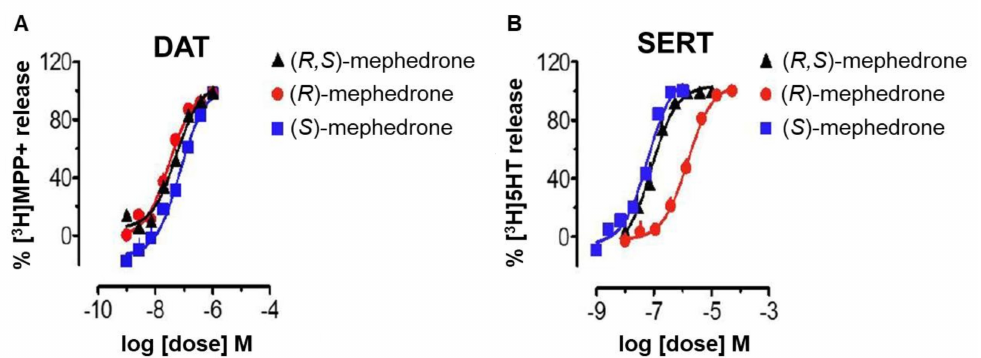
Figure 12. Effects of the enantiomers and racemate of mephedrone on monoamine release via DAT and SERT [58]. ( A ) DAT: dopamine transporters; MPP + : 1-methyl-4-phenylpyridinium (substrate for DAT); ( B ) SERT: serotonin transporters; 5HT: 5-hydroxytryptamine